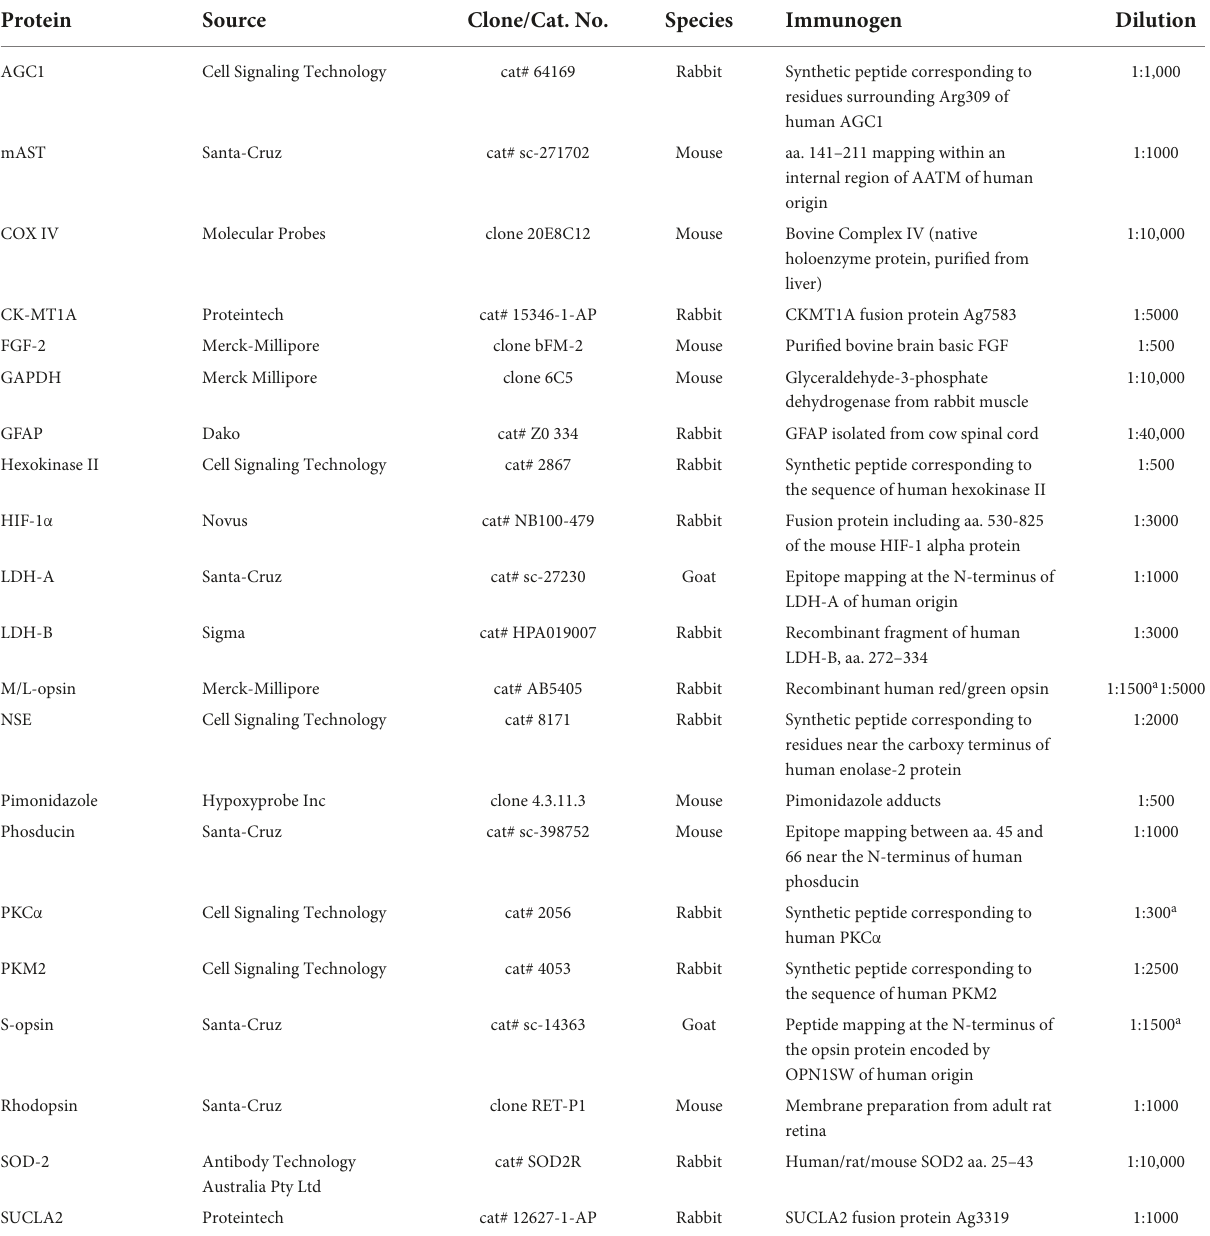
TABLE 1 Primary antibodies used in the